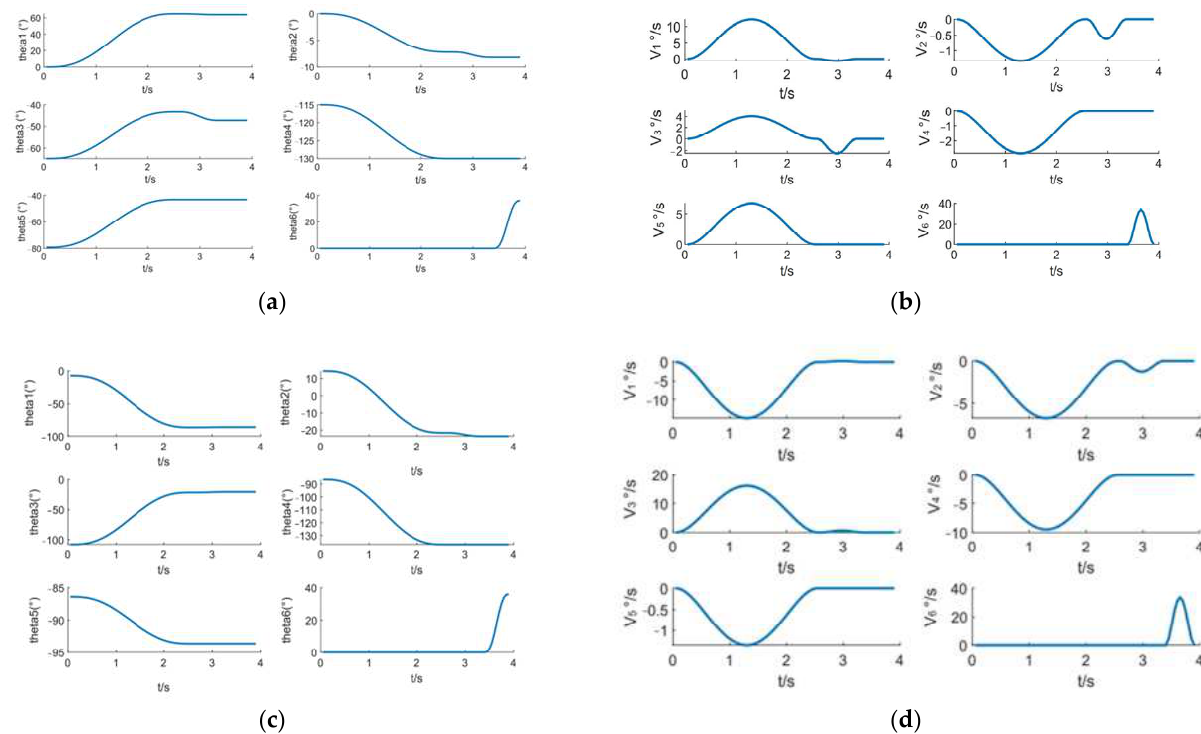
Figure 15. The motion simulation process of the pickable area with the double-arm. ( a ) Initial posi- tion. ( b ) Collision detection. ( c ) Dual robotic arm planning path. ( d ) Locating the fruit. ( e ) Grabbing the fruit. ( f ) Separating the fruit.